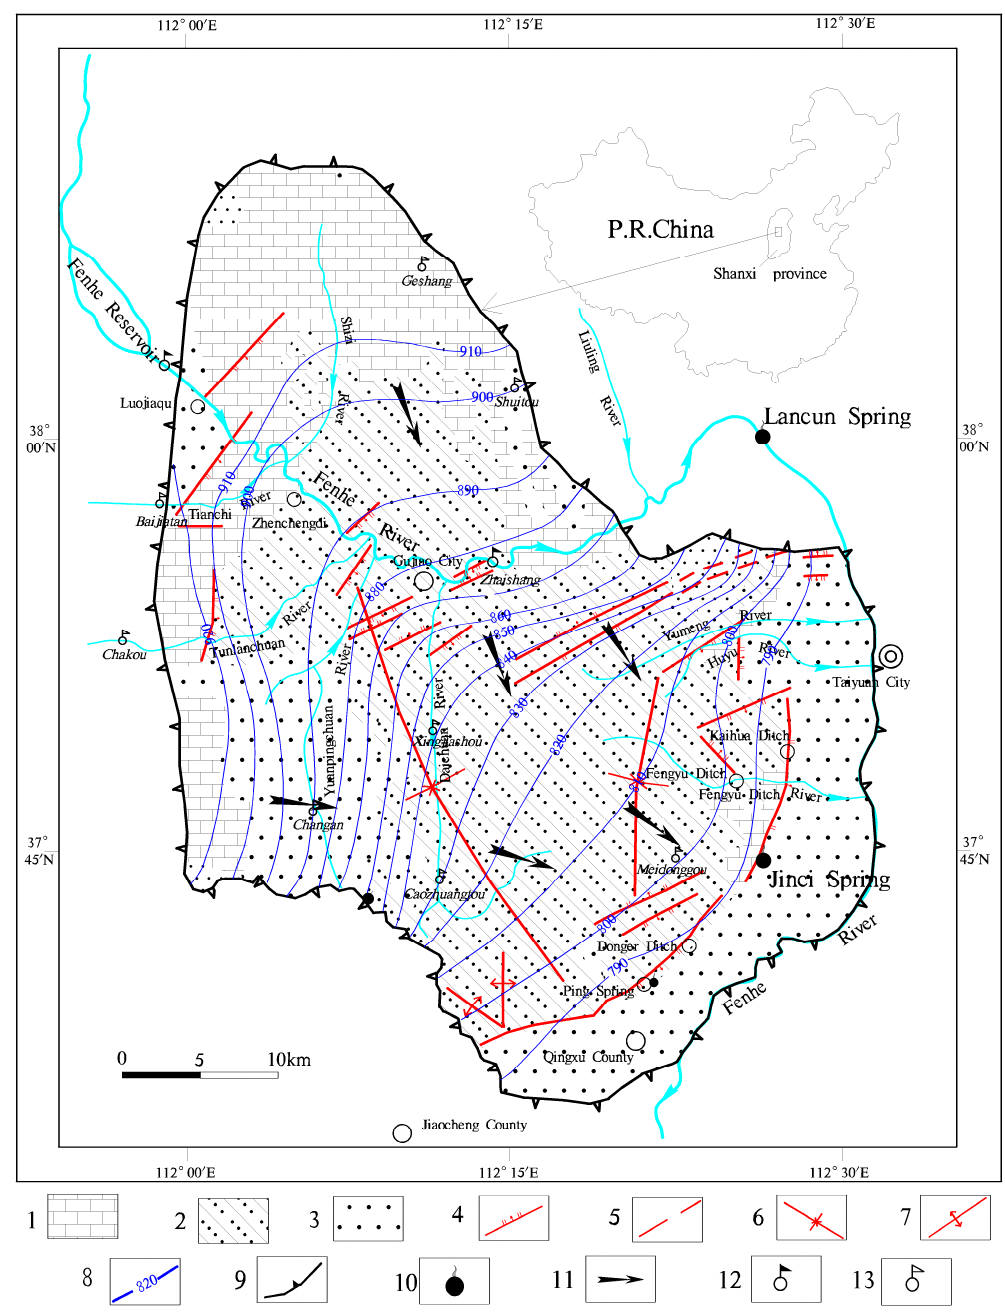
Figure 1. Simplified hydrogeological map of the Jinci Spring region. 1. Cambrian and Ordovician carbonate rocks; 2. Carboniferous-Permian clastic rocks; 3. Quaternary loose sediments; 4. fault structure; 5. buried fault; 6. syncline structure; 7. anticline structure; 8. groundwater contour lines; 9. boundary of spring region; 10. spring; 11. groundwater flow direction; 12. hydrologic station; 13. precipitation station.